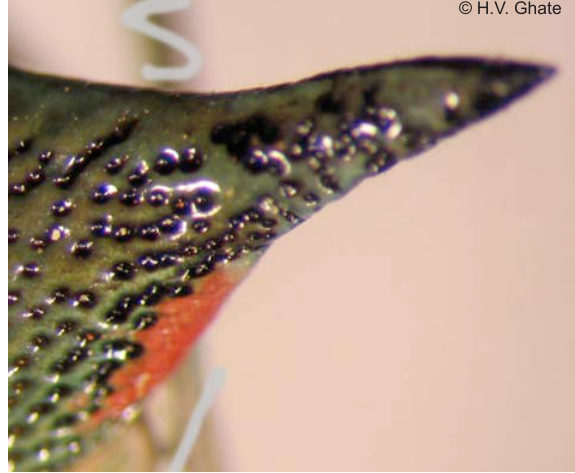
Image 9. Sabaeus humeralis : close up of pronotal angle (dorsal view) showing dark punctures between shining green area with reddish ochraceous spot on posterior margin